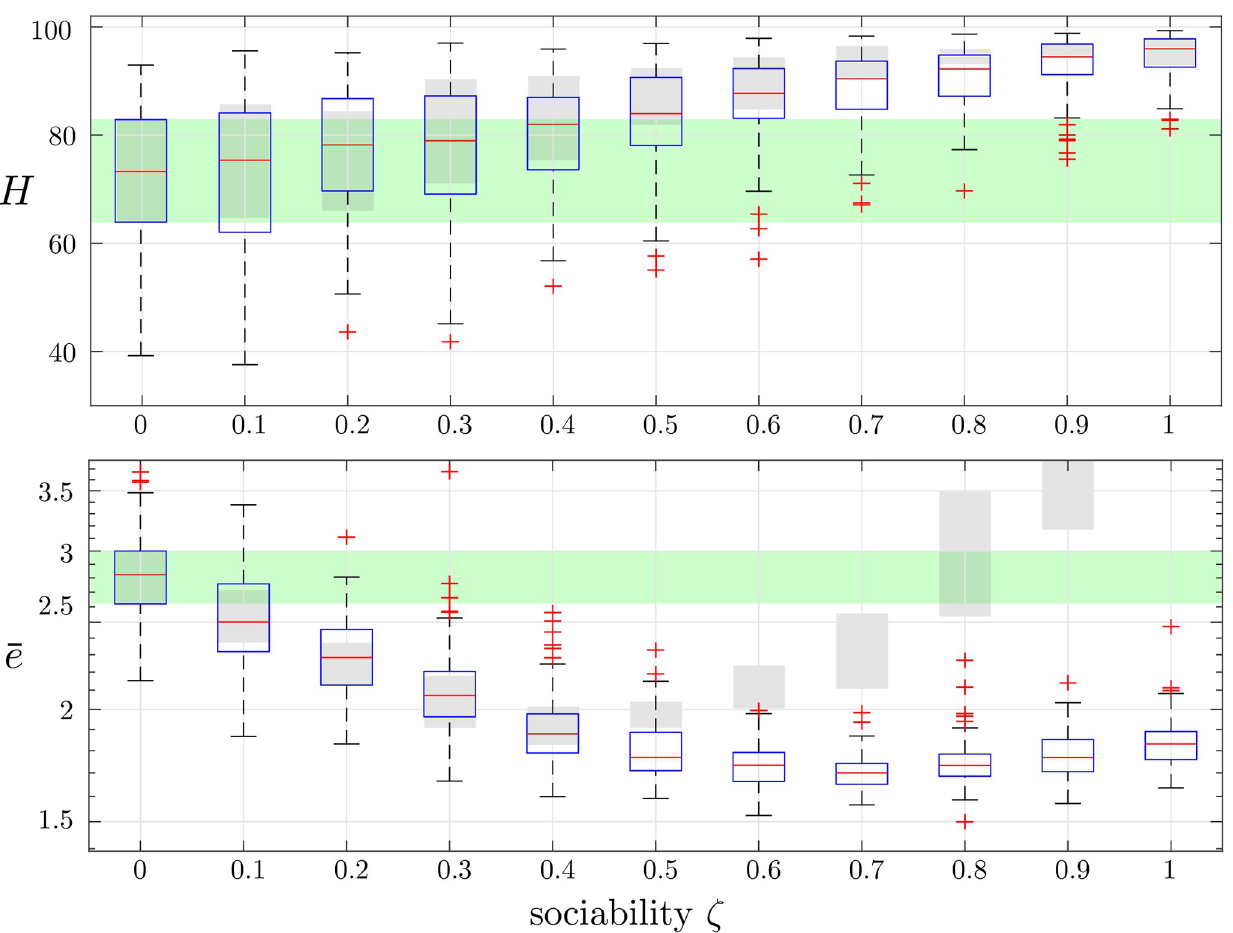
Fig 4. Box plots of the realizations of the herding intensity H (top panel) and the market efficiency � e (bottom panel) obtained with 100 simulations of our model for each value of z when data are anonymized. The green-shaded area corresponds to the box obtained for the case z = 0. The gray-shaded boxes replicate those reported in Fig 1 in the absence of